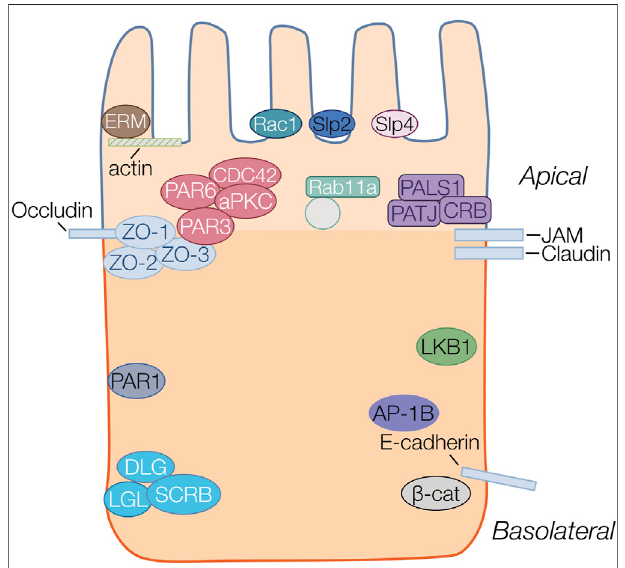
FIGURE 1 | Protein complexes important in epithelial polarity. Proteins belonging to the same family or complex are represented in the same color. Four major polarity complexes are highlighted: the apically localized ERM (brown), Crumbs (Crb/Pals1/Patj) (purple) and Par complex (Par3/Par6/ Cdc42/aPKC) (red) and the basolateral Scribble (Scrb/Lgl/Dlg) (aqua). The basolateral proteins Par1 (blue), LKB1(green) and AP-1B (purple) are also highlighted. Structural proteins including actin, and junctional proteins occluding, JAM, claudin and E-cadherin are all represented as rectangles. Par3 localizes to the cytoplasmic scaffolding Zonula Occludens (ZO) protein anchored to the membrane by occludin at the apical junctions. The ERM proteins provide anchorage to actin fi laments at the apical membrane. Synaptotagmin-like proteins (Slp2 (navy) and Slp4 (pink) are anchors for vectorial transport towards the apical membrane. Transcytotic vesicles, transiting from basolateral to apical surfaces are marked by Rab11a to deliver and maintain the recycling of apical membrane proteins at the apical